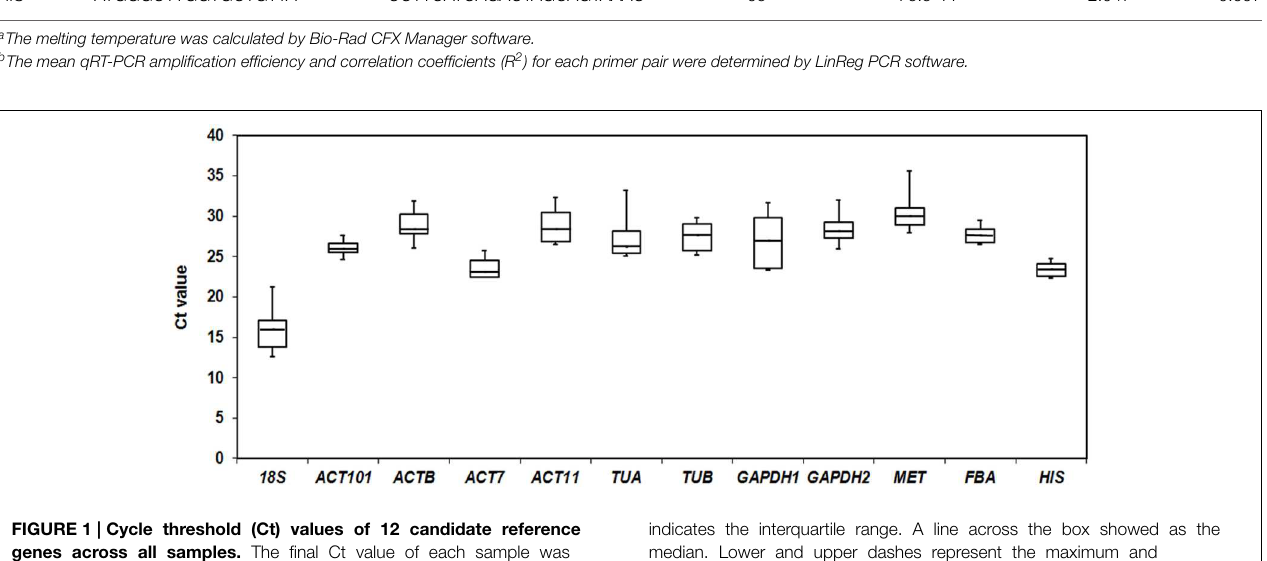
indicates the interquartile range. A line across the box showed as the median. Lower and upper dashes represent the maximum and minimum